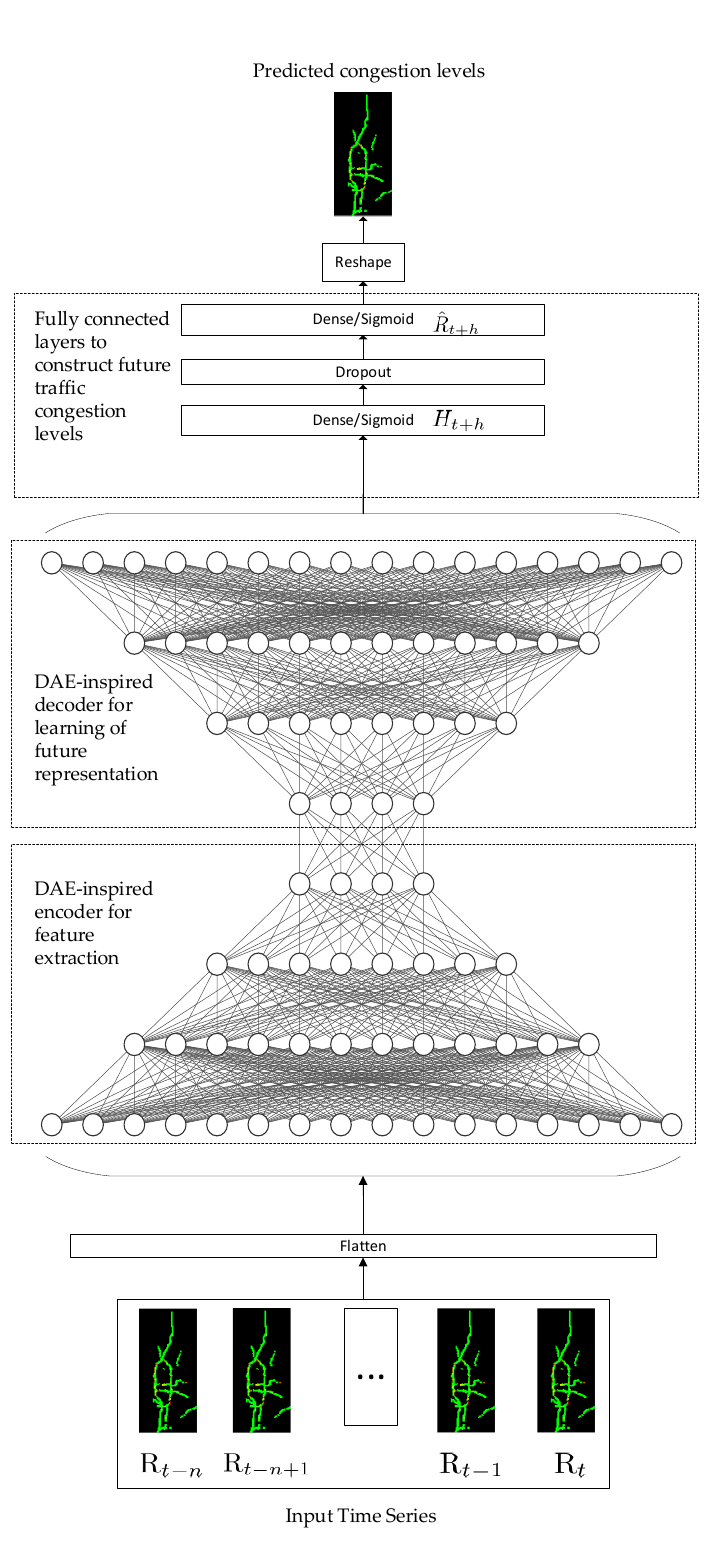
Figure 2. The architecture of our proposed deep neural network for traffic congestion